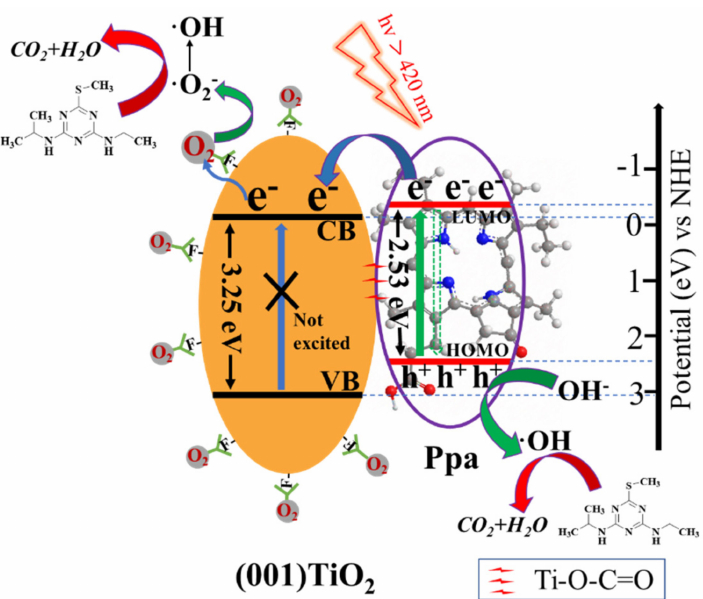
Figure 7. The schematic illustration of the Ppa/001T composite showing the charge carrier’s transfer and separation and the surface